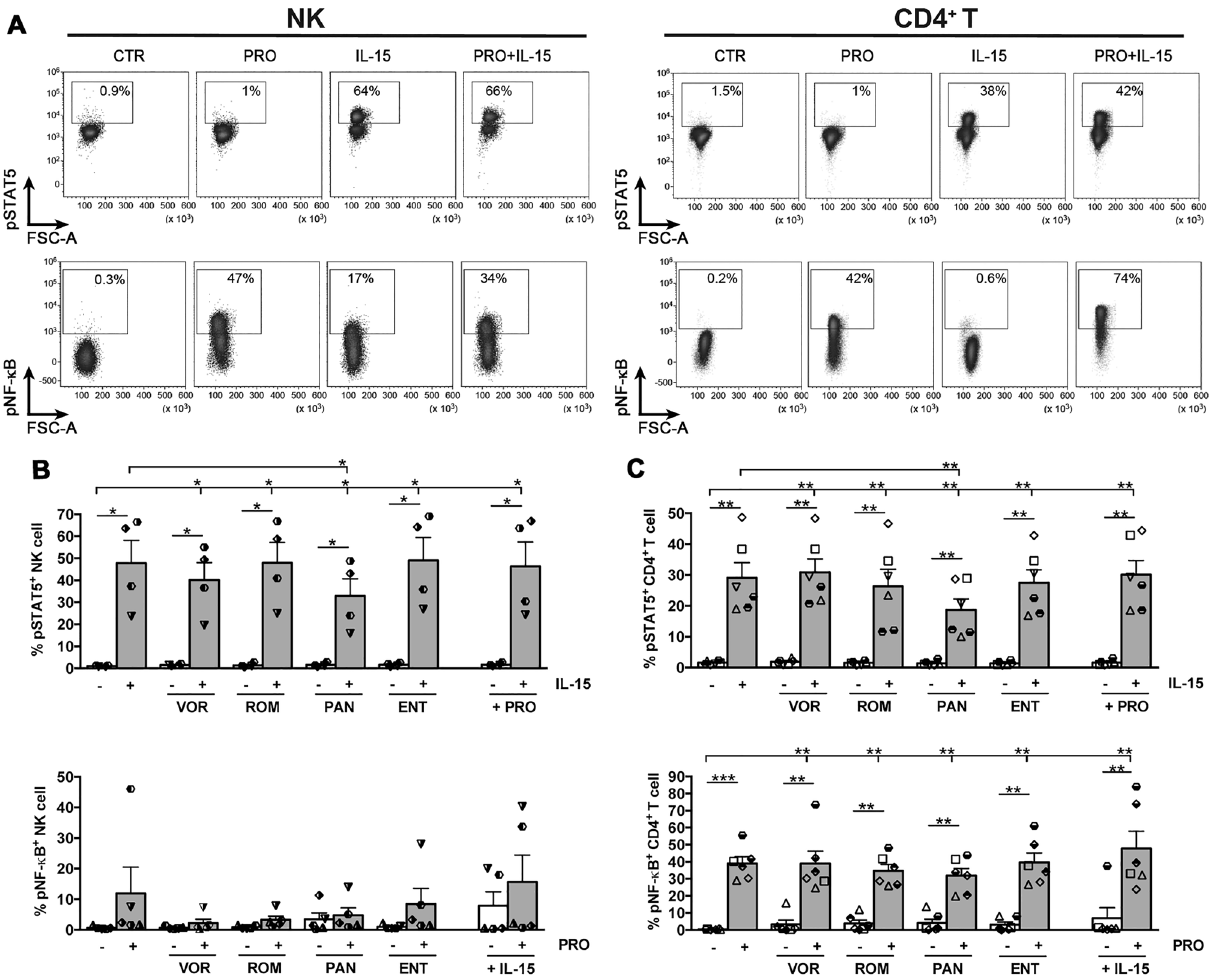
Figure 5. Induction of pSTAT5 and pNF-κB + in IL-15/LRA treated NK and CD4 + T cells. Purified NK or CD4 + T cells were cultivated overnight in serum-free medium without stimuli (CTR) or in the presence of VOR, PAN, ROM, or ENT. Then, cells were incubated at 37 °C for 15 min in fresh medium alone or containing 1 µM PRO and/or 12.5 ng/ml IL-15 and immediately fixed/permeabilized and analyzed for pSTAT5 and pNF-κB expression by FACS. ( A ) Dot plots show percentage of pSTAT5 + and pNF-κB + cells among NK and CD4 + T cells in CTR, PRO, IL-15 or PRO + IL-15 conditions for a representative experiment. ( B, C ) Bars depict mean ± SEM percentages of pSTAT5 + and NF-κB + NK cells ( B , n = 4–5) and T cells ( C , n = 6). Each symbol represents one donor. Statistics was performed using paired t -test versus unstimulated control, IL-15 alone, and LRA without IL-15. * p < 0.05; ** p <